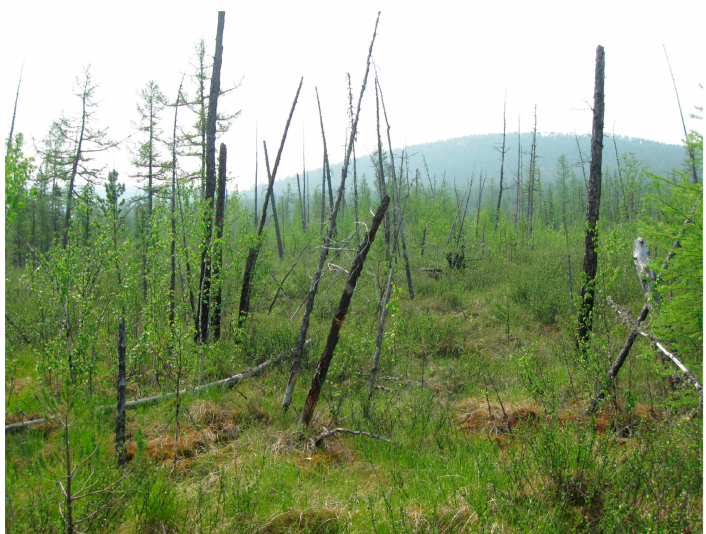
Figure 7. Traces of a forest fire in a permafrost sparse stand located within a waterlogged bottom of a stream